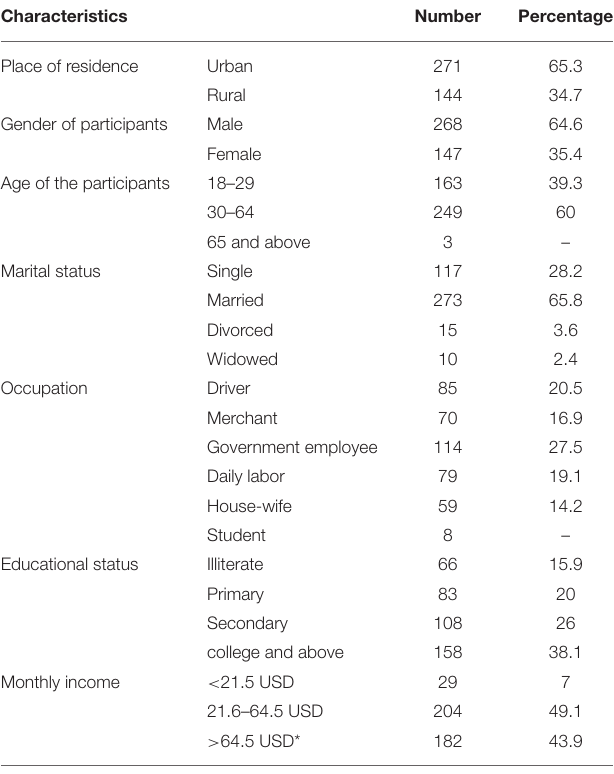
TABLE 1 | Demographic characteristic of study participants on the assessment of the risk of COVID-19 among Dire Dawa administration residents, Eastern Ethiopia, May 2020 ( N = 415).